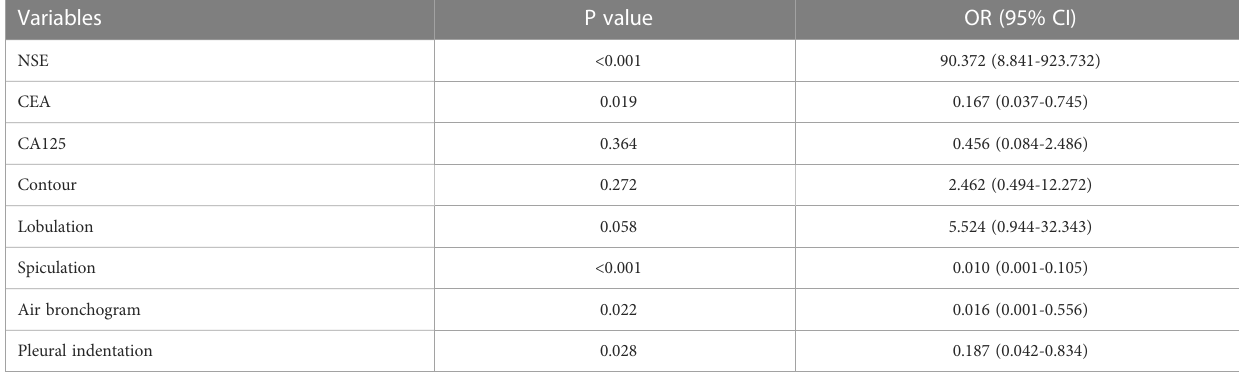
TABLE 3 Results of multivariate logistic regression analysis for classifying PSCLC and PADC in the training set. Variables